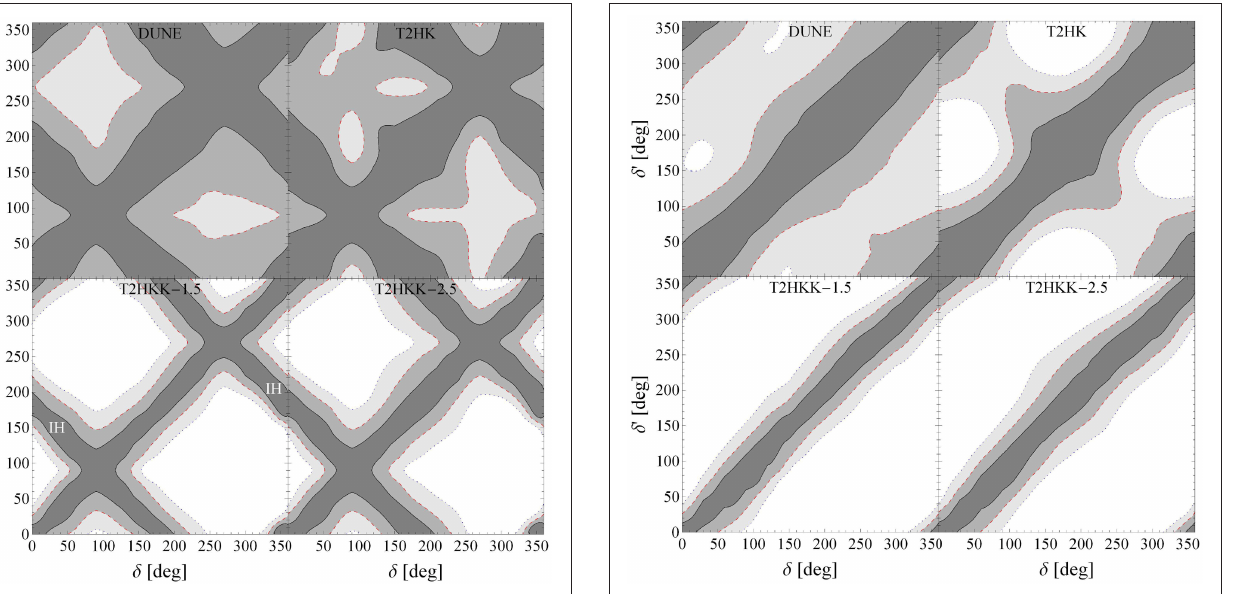
FIGURE 13 | 1 σ , 2 σ , and 3 σ contours for extracted value of CP-violating phase δ ′ at DUNE, T2HK, T2HKK with 1.5 ◦ off-axis angle and T2HKK with 2.5 ◦ off-axis angle vs. true value of δ . Normal mass ordering is assumed and taken to be unknown. The values of ǫ ee , ǫ e µ and ǫ e τ are allowed to vary. The parameters that are not shown are marginalized. This plot is taken from Liao et al. [ 221], published under the terms of the Creative Commons Attribution Noncommercial License and therefore no copyright permissions were required for its inclusion in this manuscript. We would like to thank D. Marfatia for sending the original figure.